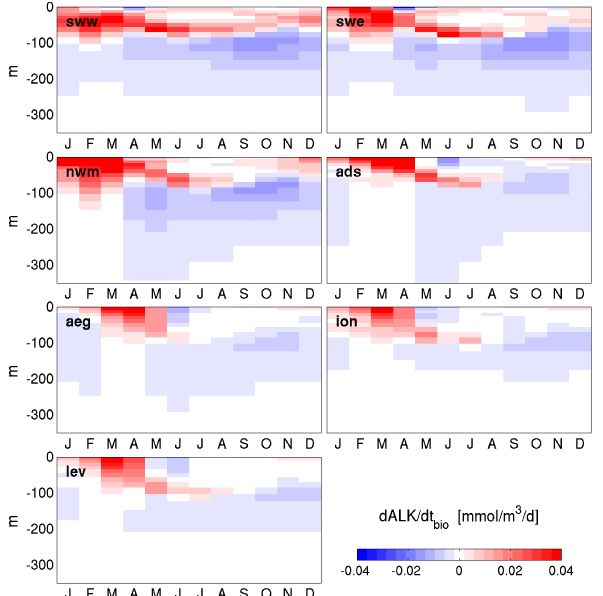
Figure 7. Annual evolution of the mean sub-basin average vertical profiles of the biological term of ∂ ALK equation. Monthly values Figure 8. Annual evolution of the mean sub-basin average vertical ∂t are averaged considering only areas deeper than 200m. profiles of the transport term of ∂ ALK equation (lower panels), and ∂t evolution of evaporation minus precipitation term (upper panels). Monthly values are averaged considering only areas deeper than 200m.